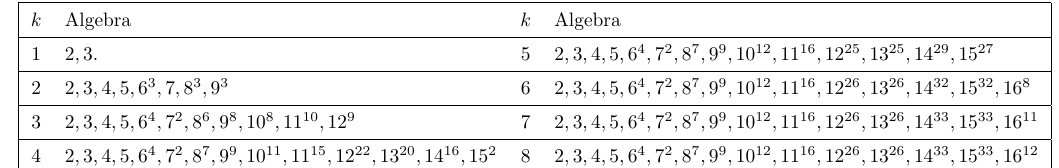
Table 3 . The algebra obtained from the vacuum character for the coset model SU(3) various k values. The algebra stabilizes by k =